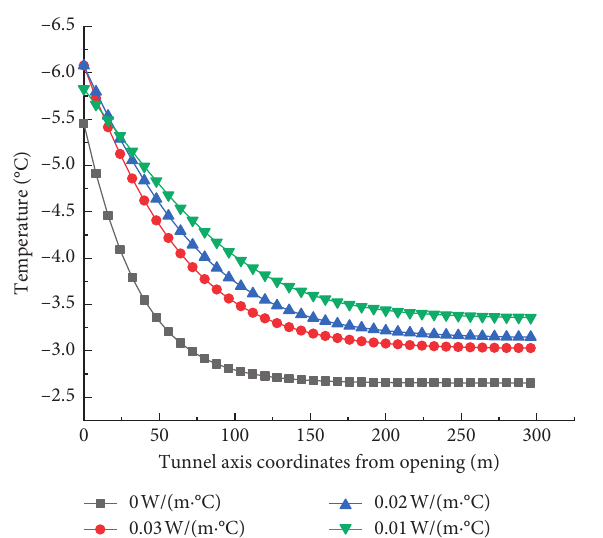
Figure 24: Distribution characteristics of the annual average air temperature vault in the tunnel axis under different thermal